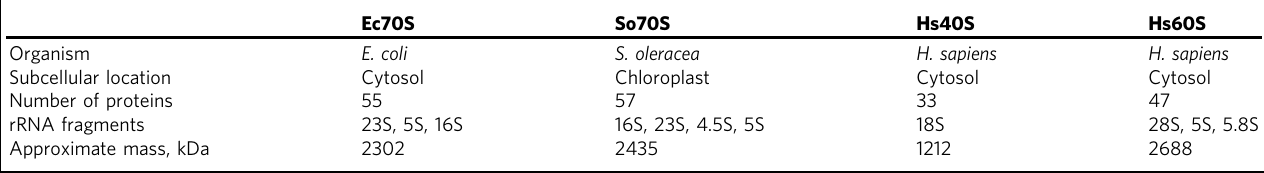
Table 1 Information on the investigated ribosomal